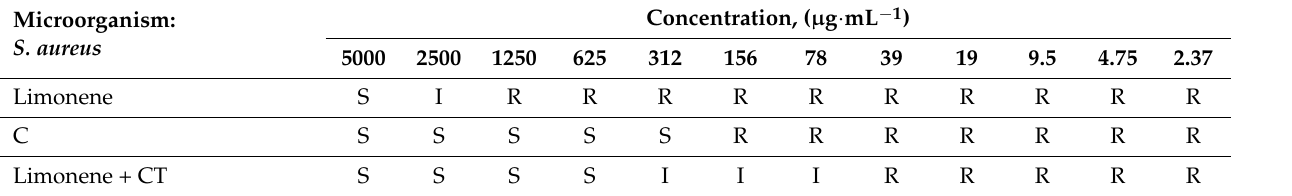
Table 5. Susceptibility of S. aureus at different